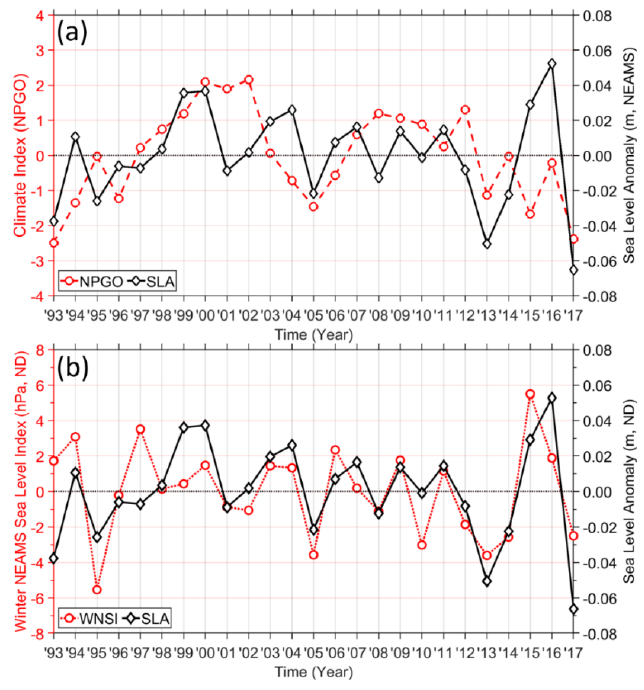
Figure 9. Time series of winter NEAMS-mean sea level anomalies (black line) and ( a ) the North Pacific Gyre Oscillation (NPGO) index (red dashed line) and ( b ) winter NEAMS-mean sea level index based on local atmospheric pressure anomaly (WNSI, red dotted line) from 1993 to 2017. Correlation coe ffi cients are ( a ) 0.41 with p -value = 0.04 and ( b ) 0.62 with p -value < 0.01,